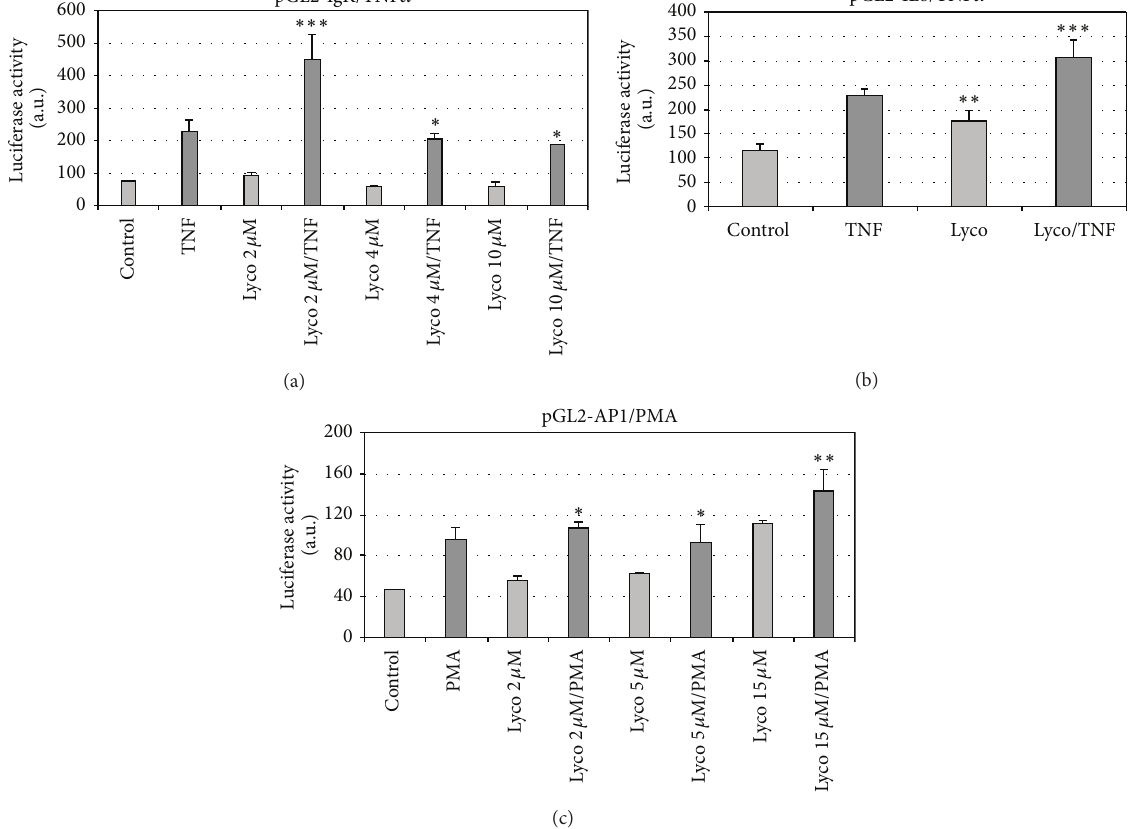
Figure 3: Modulation by lycopene of reporter gene activity in THP1 cells. THP1 cells were transfected using one of the luciferase reporter genes controlled by the promoter/enhancer sequence derived from either the IgK gene (pGL2-IgK-luc) (a) or the IL-8 gene (pGL2-IL-8-luc) (b). The plasmid pGL2-AP1-luc (c) contains the AP1 specific sequence. After 12 h transfection, cells were washed and fresh medium with or without lycopene at the indicated concentration was added, and culture continued for 2 h. Then, according to assays, TNF 𝛼 ((a), (b)) or PMA (c) was added and culture was resumed for 6h. Cells were harvested, lysed, and placed at − 80 ∘ C. Luciferase activity was recorded. Values are means ± SD ( 𝑛 = 8 ). Assays treated with lycopene were compared to corresponding assays without lycopene. ∗∗∗ 𝑃 < 0.01 ; ∗∗ 𝑃 < 0.05 ; ∗ , nonsignificantly